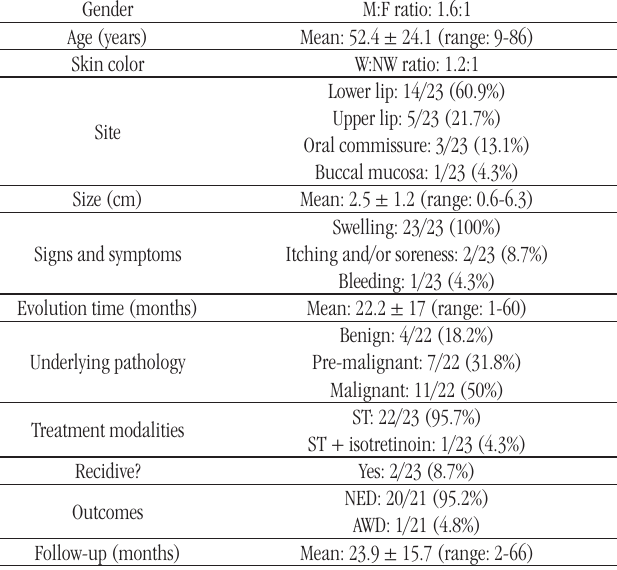
TABLE 2 – Summary findings from the 23 patients with CH occurring on the oral